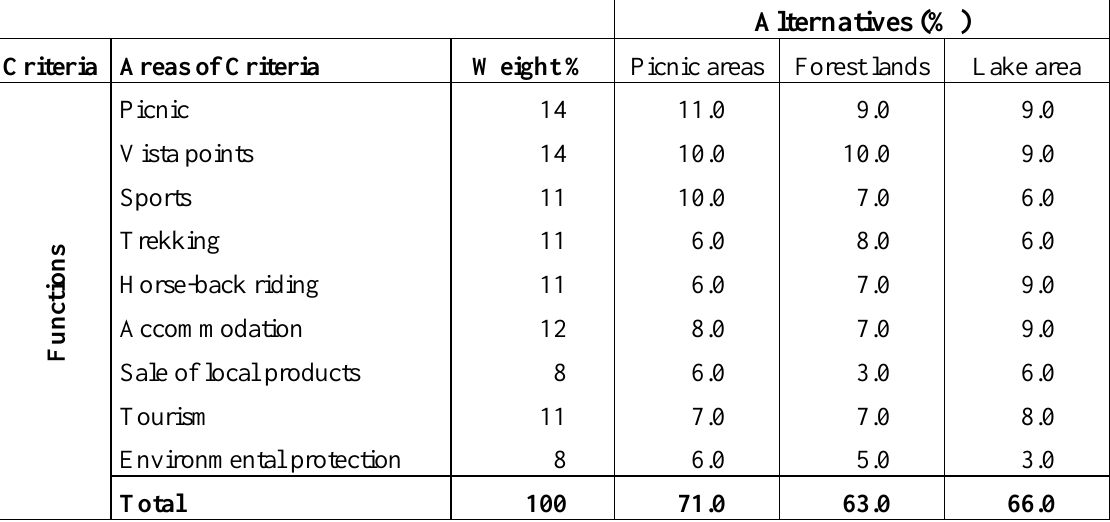
Table 4. Schematic representation of goal-value matrix of the BLANP opens space.